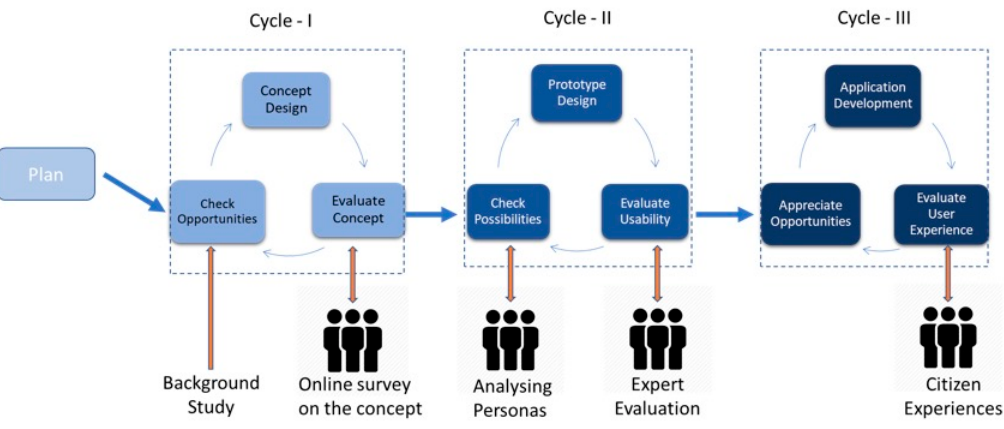
Figure 2. Diagram of the process (adapted from the Form IT model) [16].